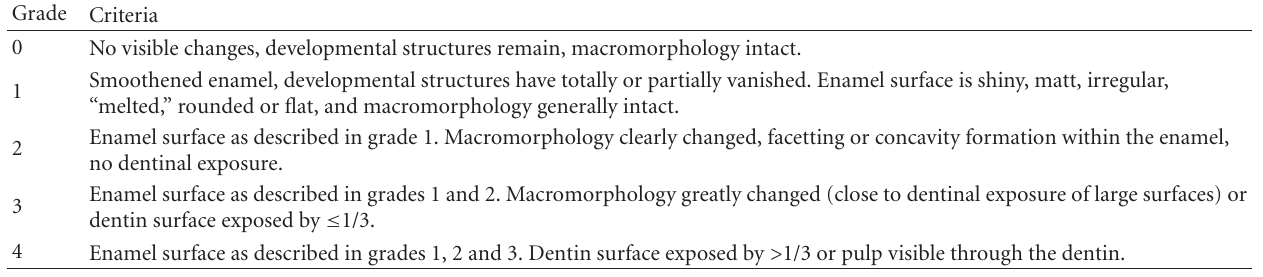
Table 2: Ordinal scale used for grading severity of dental erosion on buccal and lingual surfaces of maxillary anterior teeth [25]. Grade Criteria